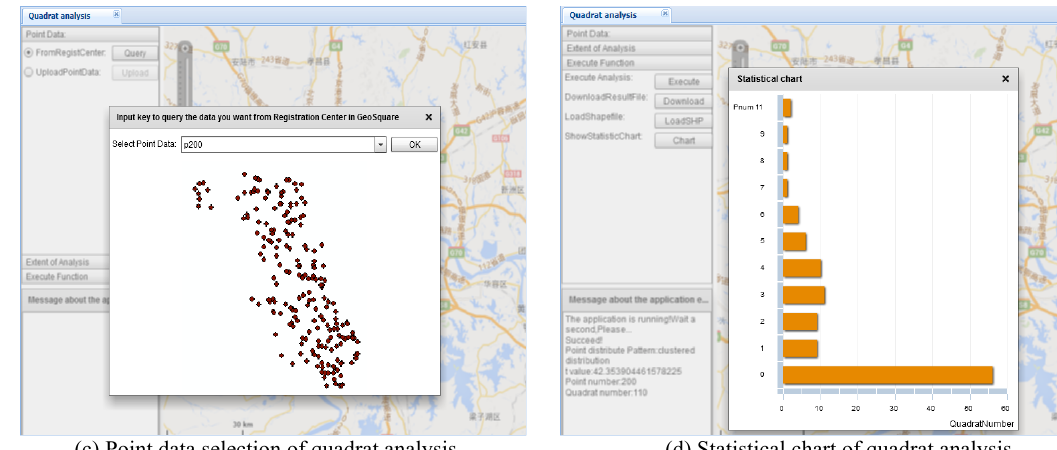
(c) Point data selection of quadrat analysis (d) Statistical chart of quadrat analysis Figure 3. RIA-based Environment for RS and GIS Teaching and